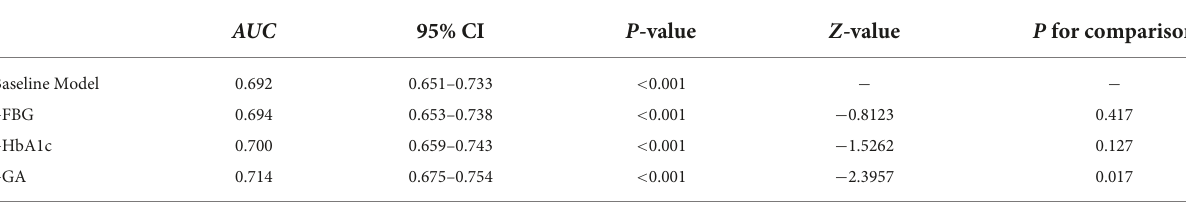
TABLE 5 The ROC curve analysis of the GA with poor ISR. AUC 95% CI P -value Z -value P for